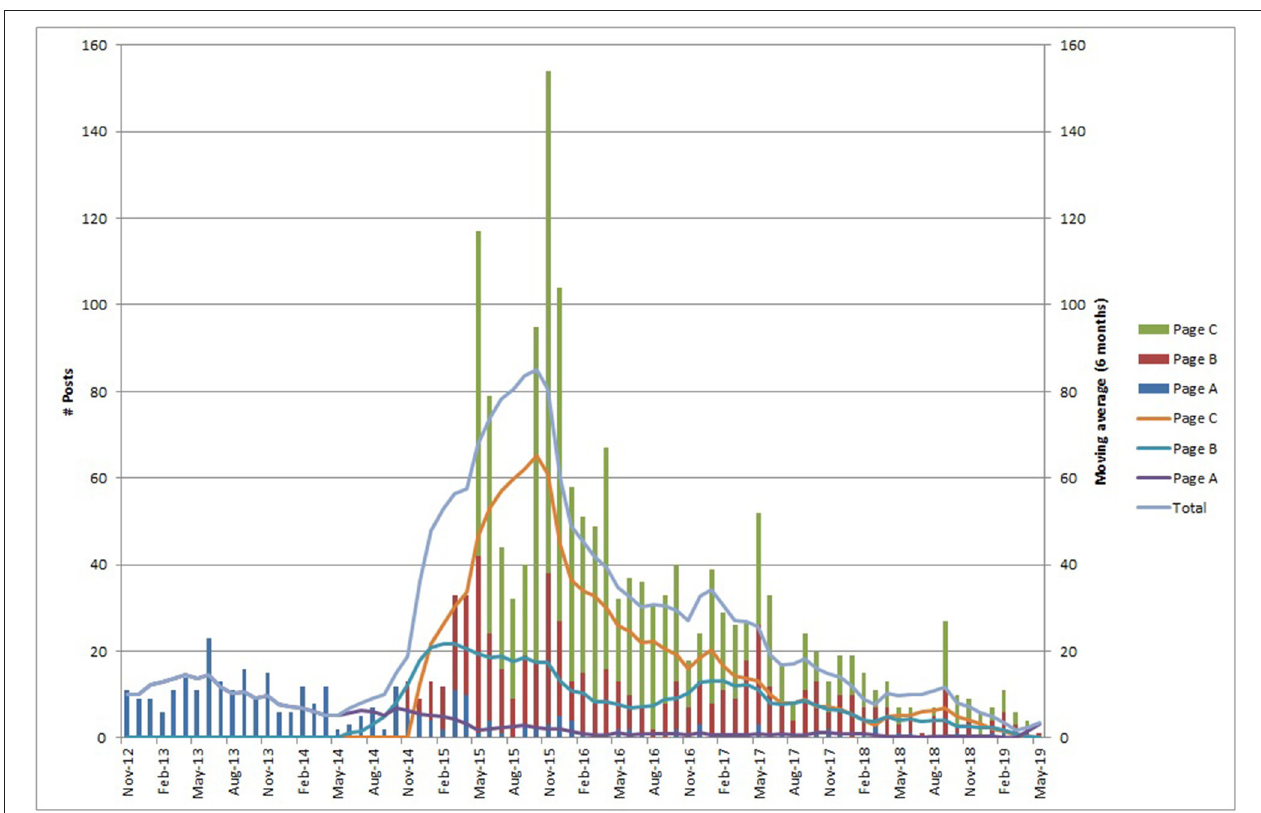
FIGURE 1 | Number of posts (columns) and moving 6 months average (lines) for our three